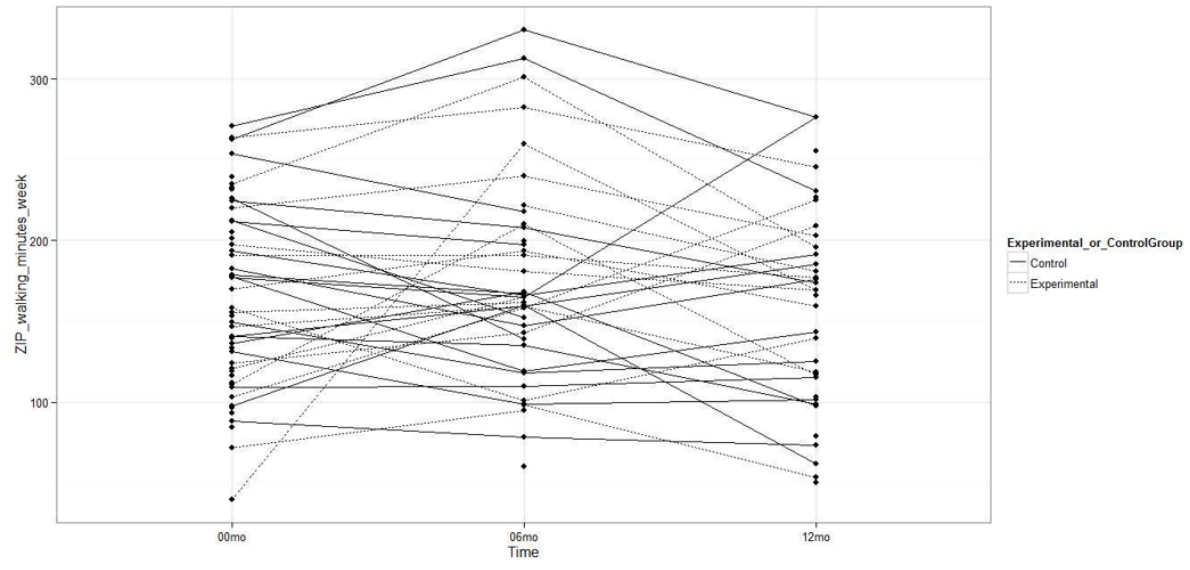
Figure 2. Light physical activity measured with the accelerometer at baseline, 6 months, and 12 months.